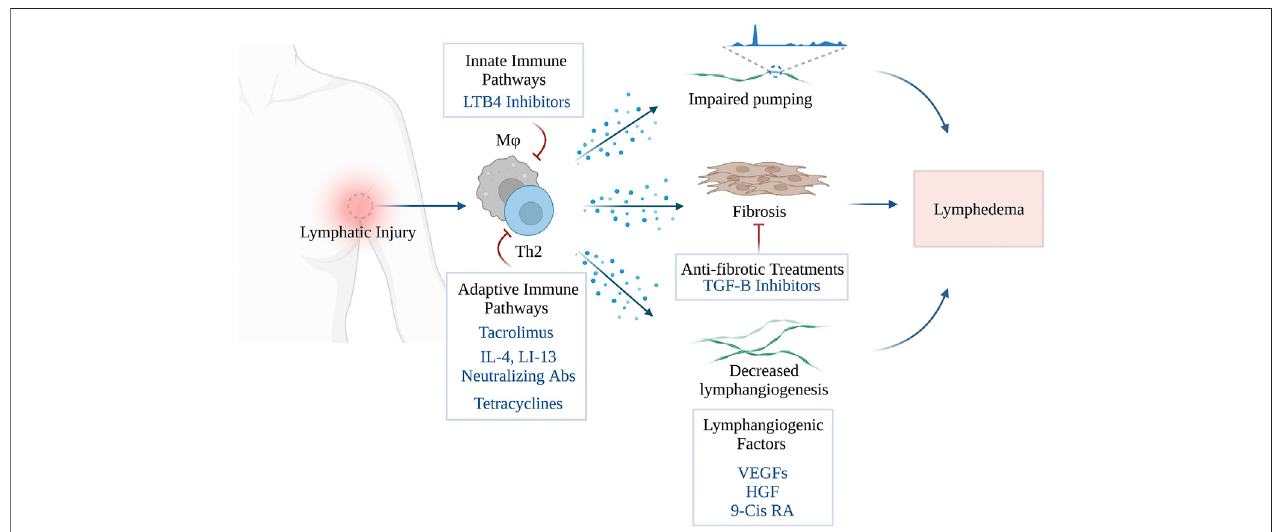
FIGURE 1 | Pharmacological Treatments of Secondary Lymphedema (Created with BioRender). Stav Brown,